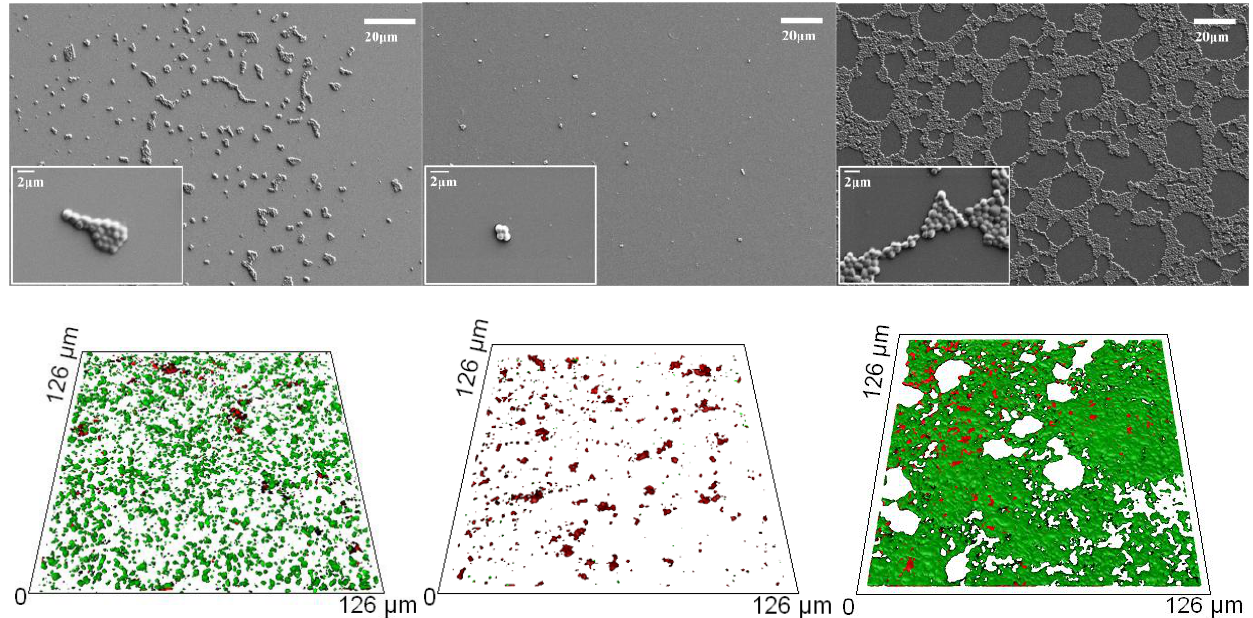
Figure 2. Representative S. aureus attachment patterns on the unmodified (left panel) glass, modified with 10 W (middle panel), and 25 W (right panel) polyterpenol thin coating after 18 h incubation. Images on the top collected using SEM; (inset) SEM images showing typical cell morphologies of the attached microorganisms. Confocal scanning laser microscopy (CSLM) images (bottom) visualize viable cells stained green and dead cells stained red with BacLight ® Dead/Live Kit (Invitrogen), scanned areas of approximately 126 μm × 126